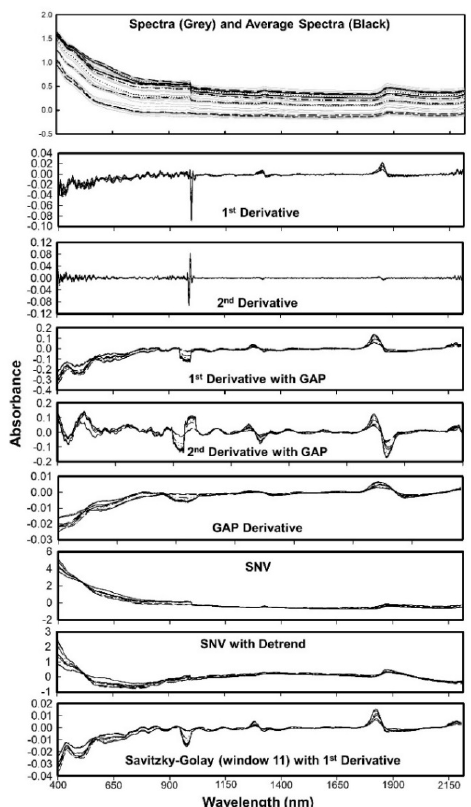
Figure 3. Spectra and the average spectra of first 10 soil samples used in this study. Effects of different preprocessing algorithms are also shown individually.